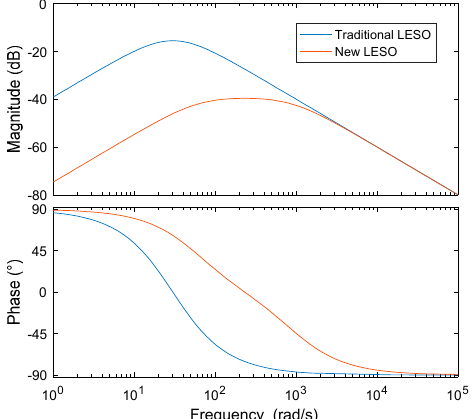
Figure 10. Frequency-domain characteristic curves of the input disturbance.